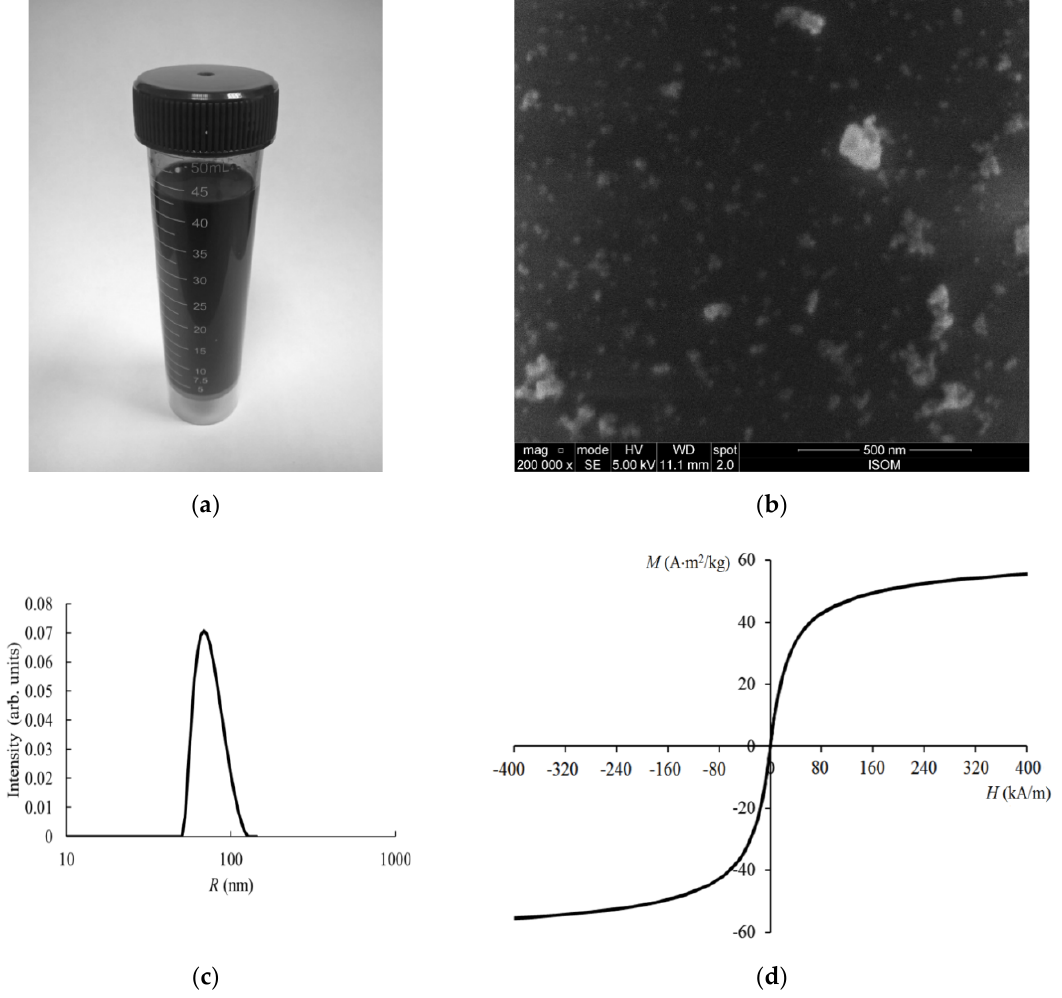
Figure 1. Physicochemical properties of the nanocomposites: ( a ) View of the obtained colloidal solution; ( b ) scanning electron microscope image; ( c ) nanoparticles radius distribution; ( d ) static magnetization reversal curve.